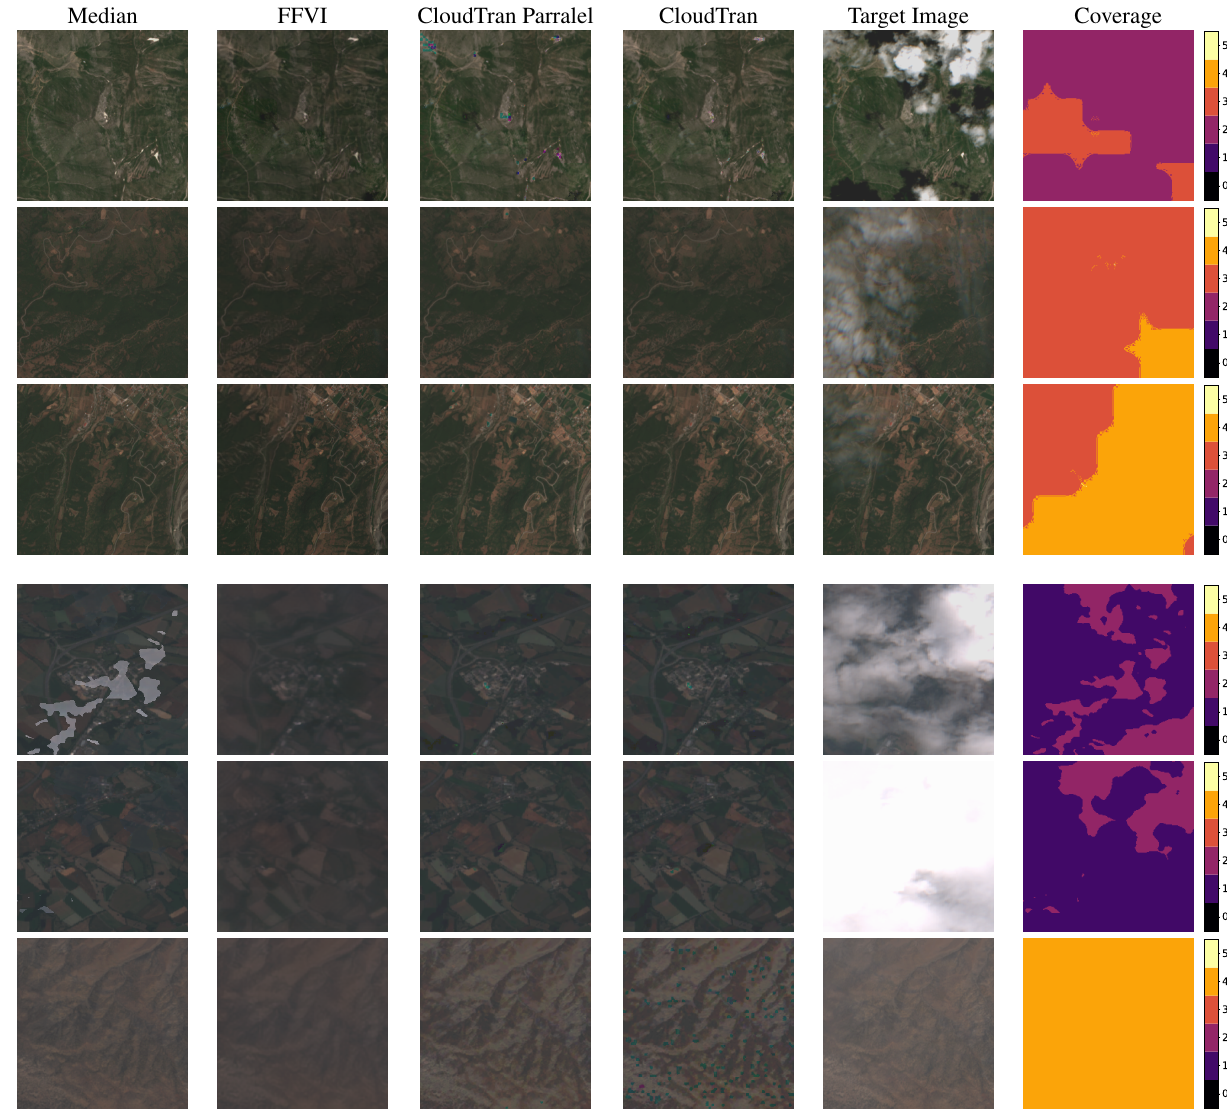
Figure 4. Random samples from test set of our dataset (top three rows) and SEN12MS-CR-TS (bottom three rows). (Best viewed on screen zoomed-in)